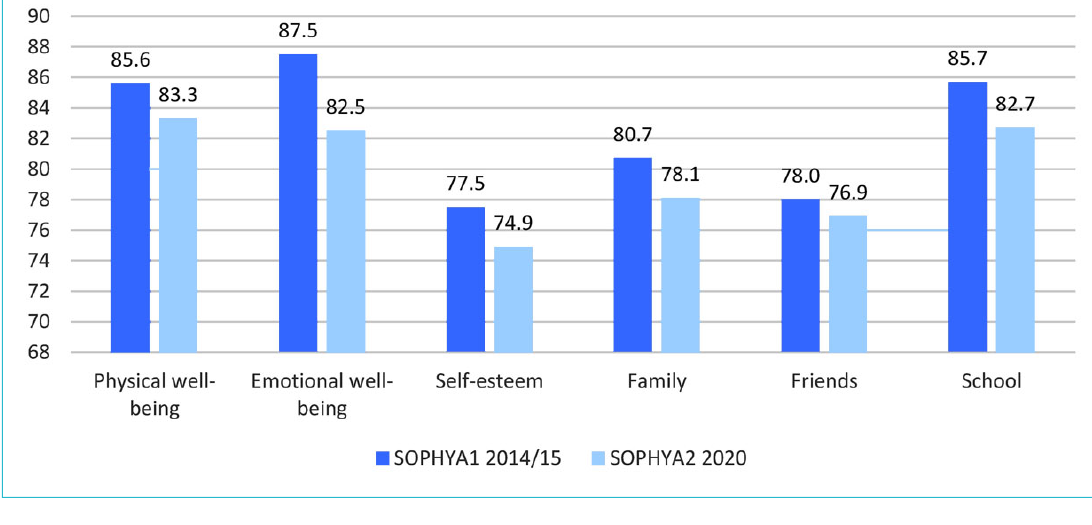
Figure 1: Comparison of adjusted a means for the different dimensions of health-related quality of life in 2014 versus 2020 (year of the COVID-19 pandemic). a Multivariate linear regression models adjusted for all characteristics which showed a significant association with health-related quality of life (supplementary Table 1): age, sex, income, language region and urbanicity. The scores of the different dimensions were between 1 and 100. The axis scale was based on the span of the interquartile ranges of the scores. * p<0.05